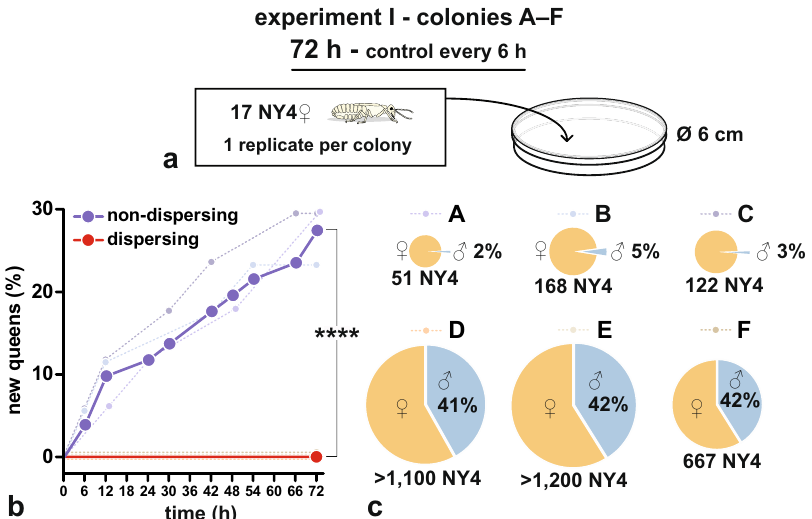
Fig. 1 Readiness of female nymphs to develop into neotenic queens. Groups of 17 NY4 ♀ from three non-dispersing (A – C) and dispersing (D – F) colonies were observed for 72 h and numbers of new NQs in the groups scored. a Experiment design. b Dashed curves indicate cumulative numbers of new NQs in individual colonies. Bold curves indicate total cumulative numbers of new NQs in non-dispersing (blue) and dispersing (red) colonies, compared using